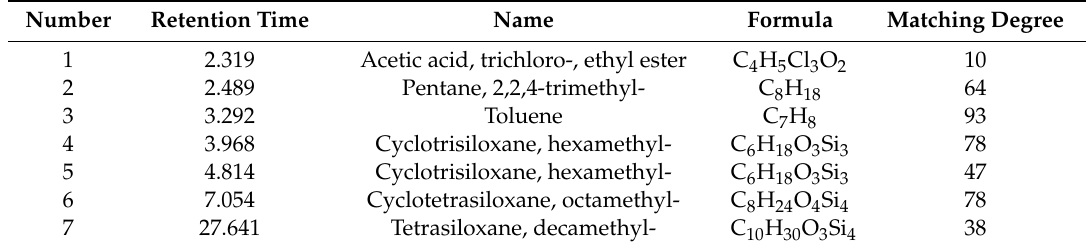
Table 6. Exhaust components absorbed by absorption liquid in